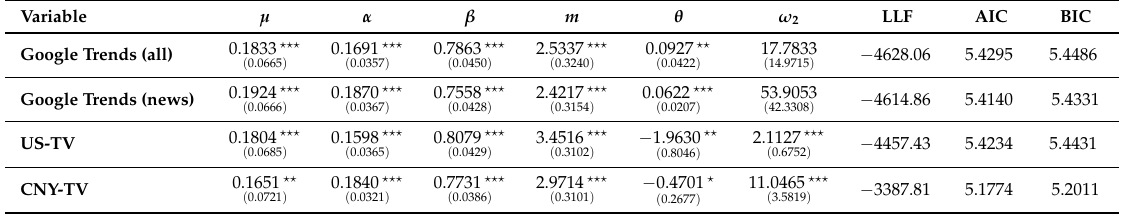
Table 7. GARCH-MIDAS for Bitcoin specific explanatory